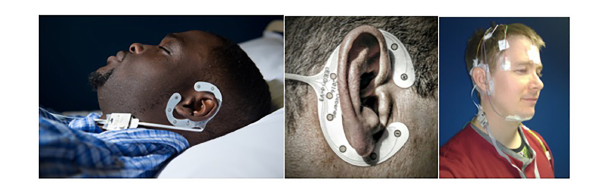
FIGURE 1 | Data collection setup. Left : cEEGrid system set up (without PSG) in sleeping position. Middle : Close up of cEEGrid electrode. Right : Simultaneous montage of standard PSG and cEEGrid setup. Consent/permission was obtained from the individuals (JE and KBM) for the publication of this image.